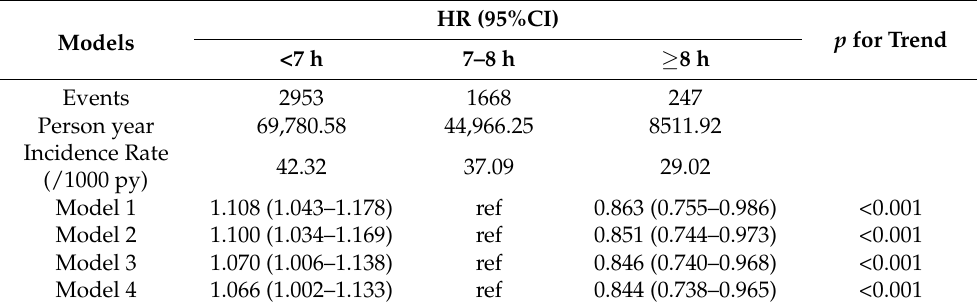
Table 2. Association of sleep duration with risk of hyperuricemia in different model.